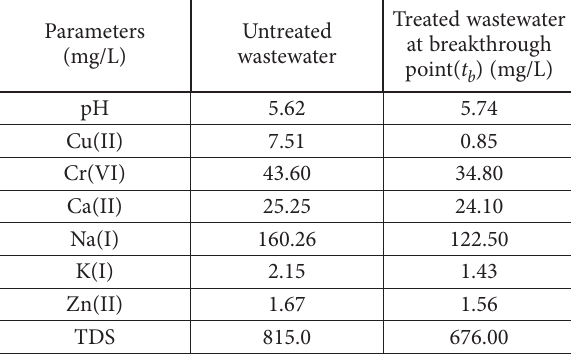
Table 3. Composition of untreated and treated wastewater